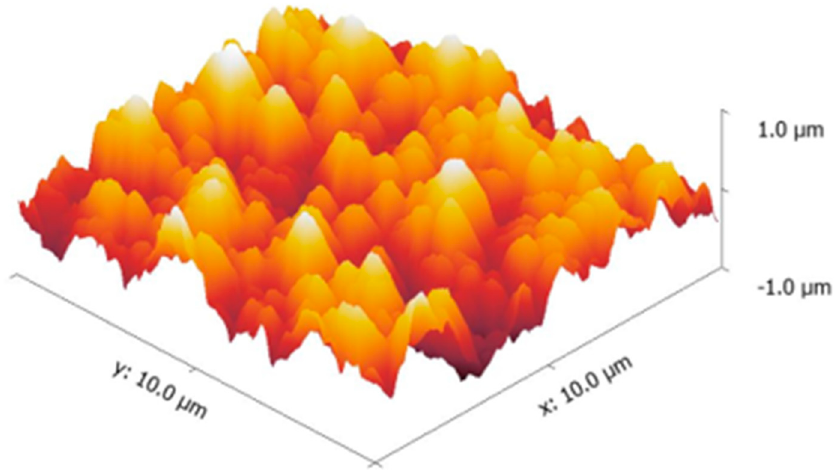
Figure 3. 3-Dimensional AFM image of the superhydrophobic copper surface.